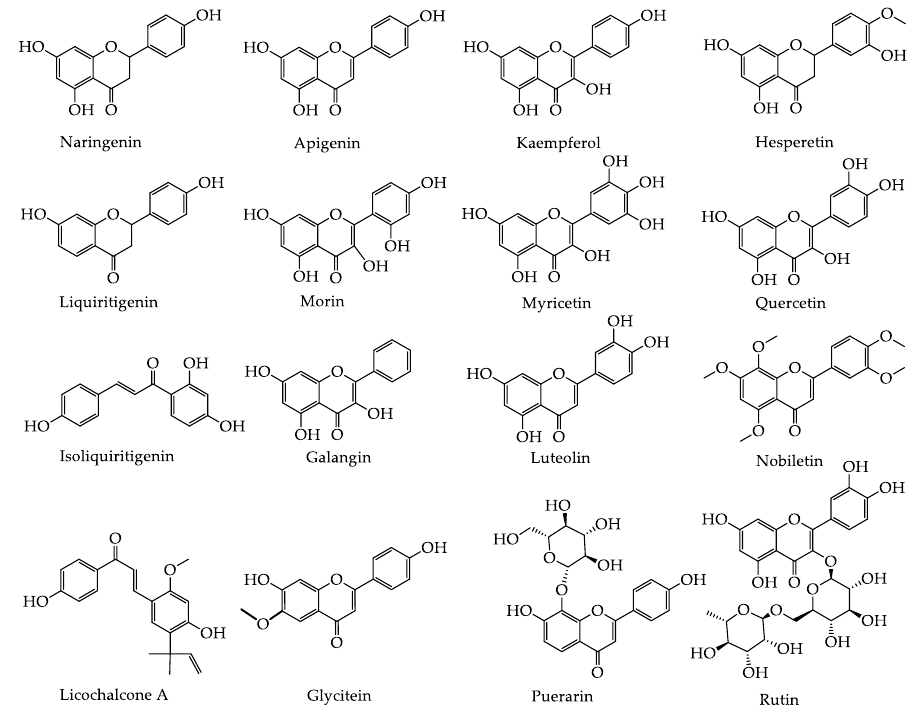
Figure 3. The basic structure of hypouricemic effects from flavonoids bioactive components in plant-based functional foods.